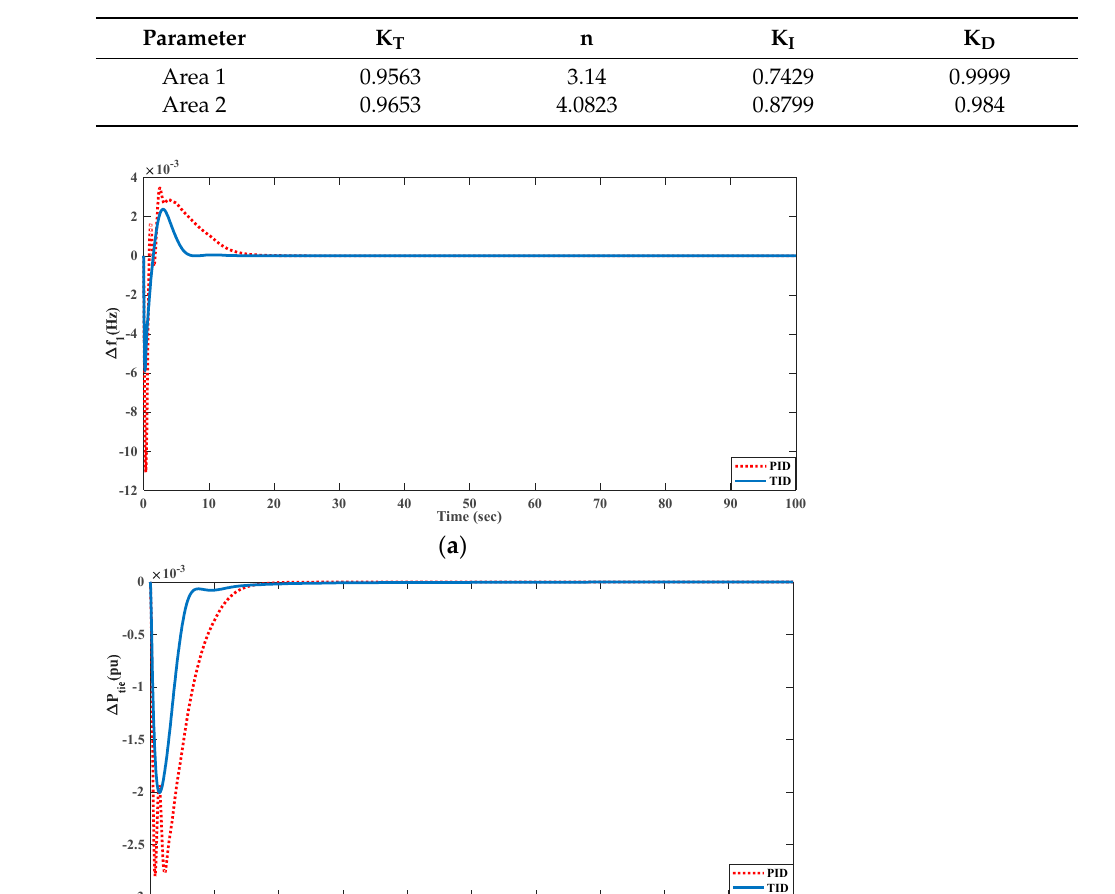
Table 3. TID parameter values for 1% SLP.